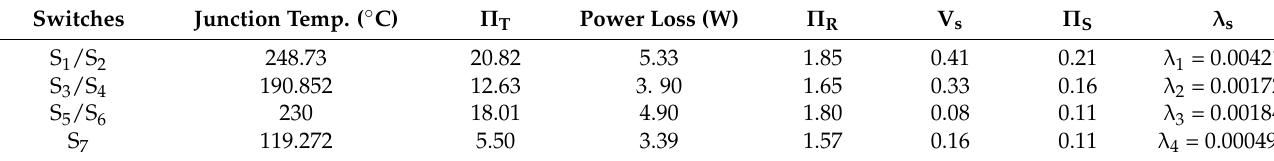
Table 3. Device failure rate parameters.